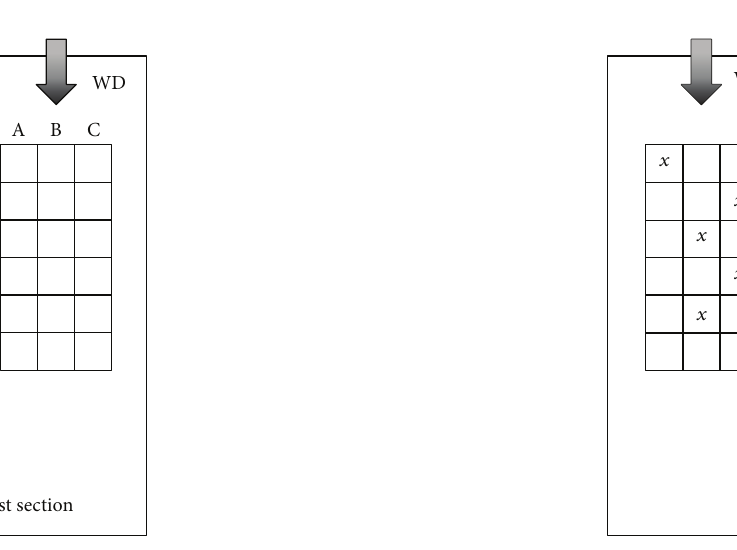
Figure 4: Test section: small-scale wind field grid.